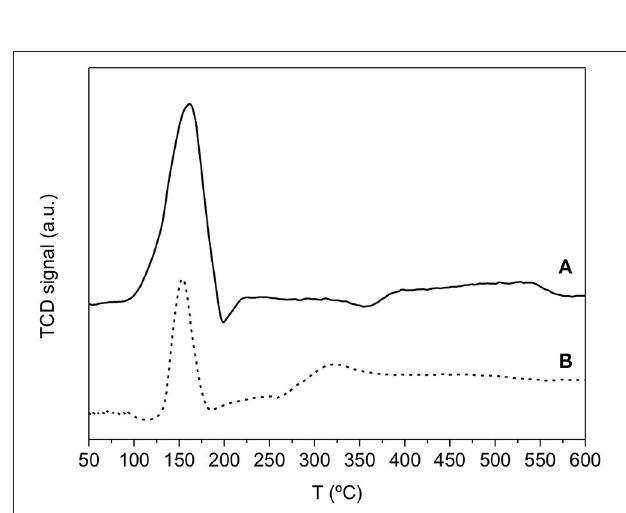
FIGURE 4 | TPR profiles of Pd-Cu loaded on TiO 2 (A) and on 20CNT-TiO 2 (B) .